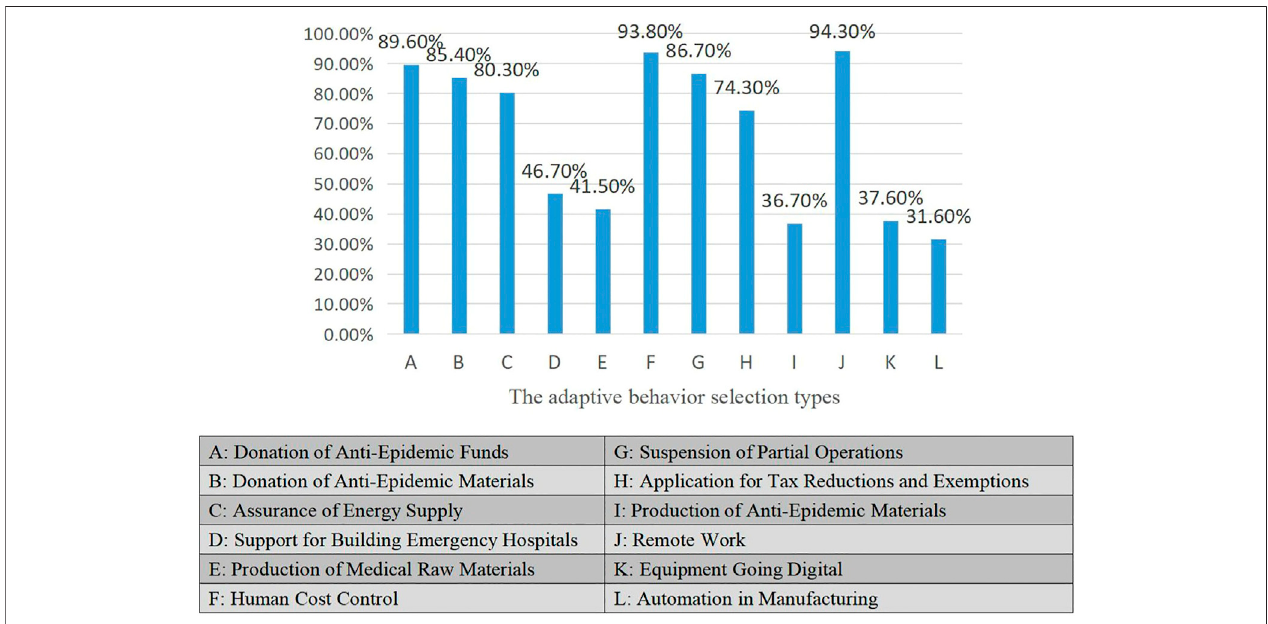
FIGURE 1 | Adaptive behaviors adopted by energy